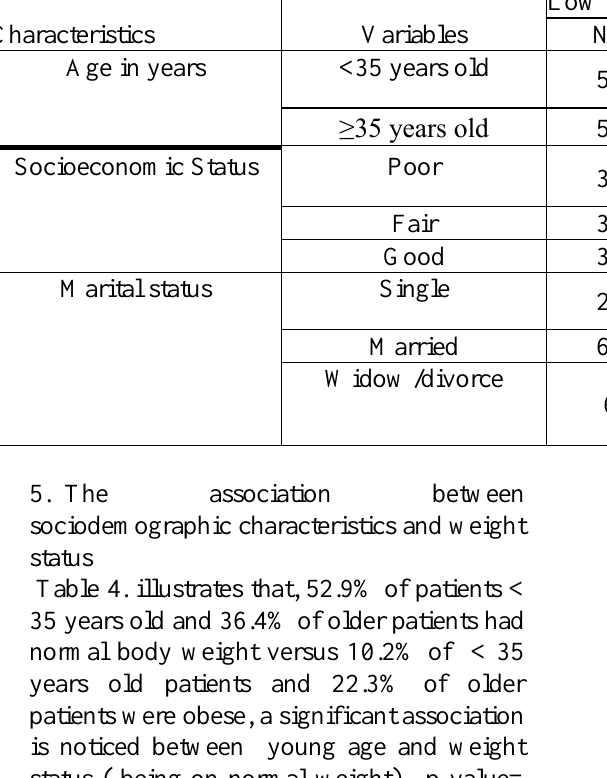
Characteristics